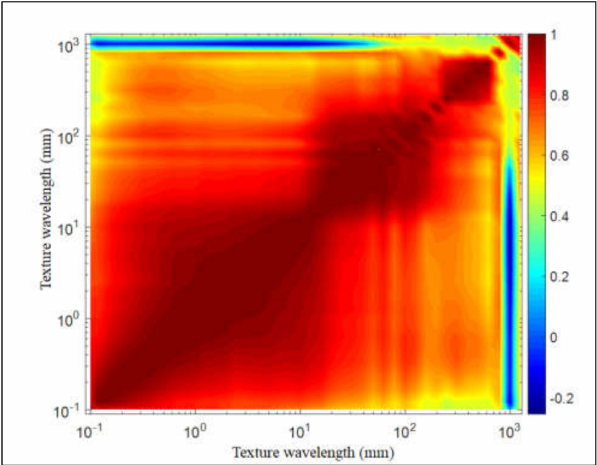
Figure 4. Intercorrelation between texture wavelength bands. The correlation coe ffi cient values are illustrated by color according to the scale on the